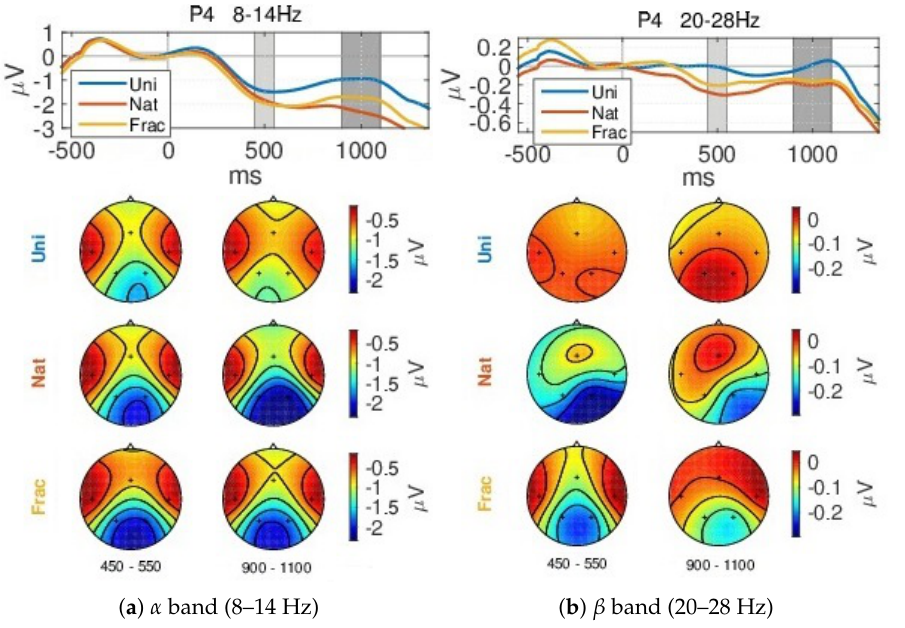
Figure A3. GA ERDs over all blocks, for Uni (blue), Nat (red) and Frac images (orange), within the: ( a ) α (8–14 Hz) and ( b ) β (20–28 Hz) frequency bands, considering the P4